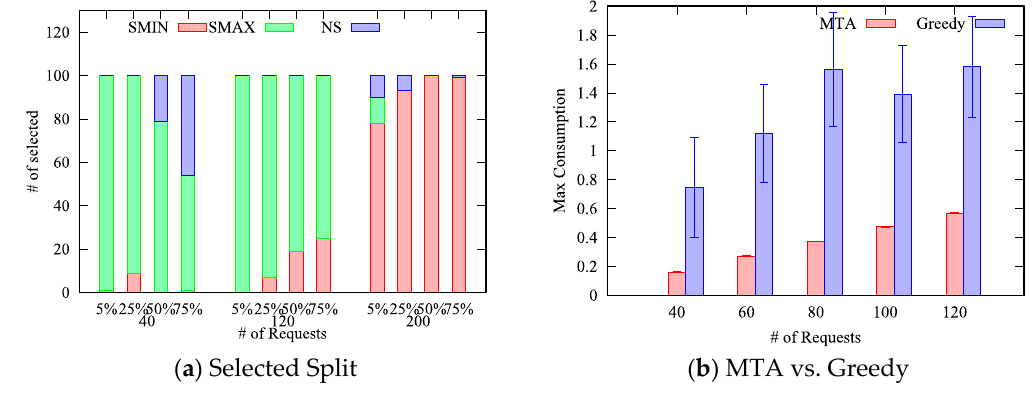
Figure 5. Split Policy and MTA vs. Greedy.